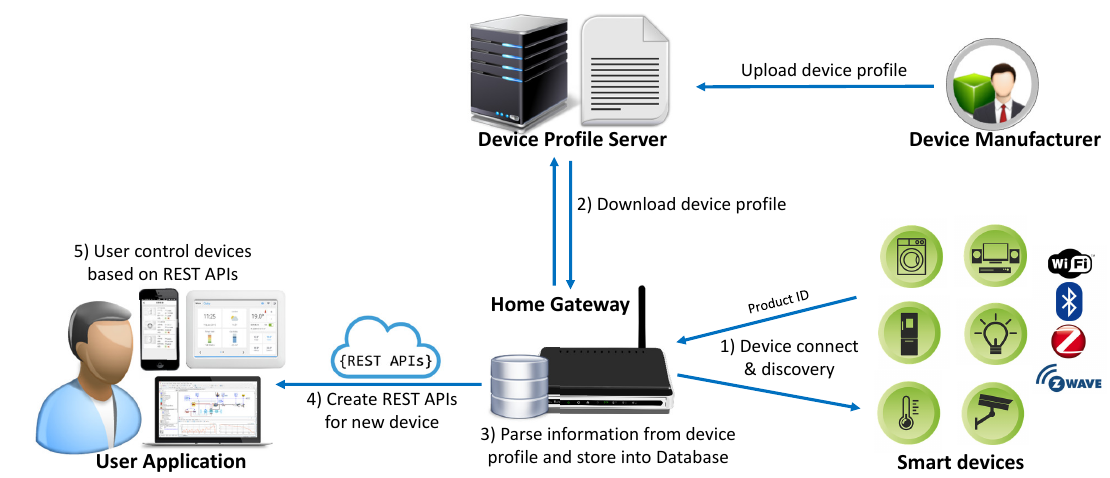
Figure 1. Components and operation of a smart home